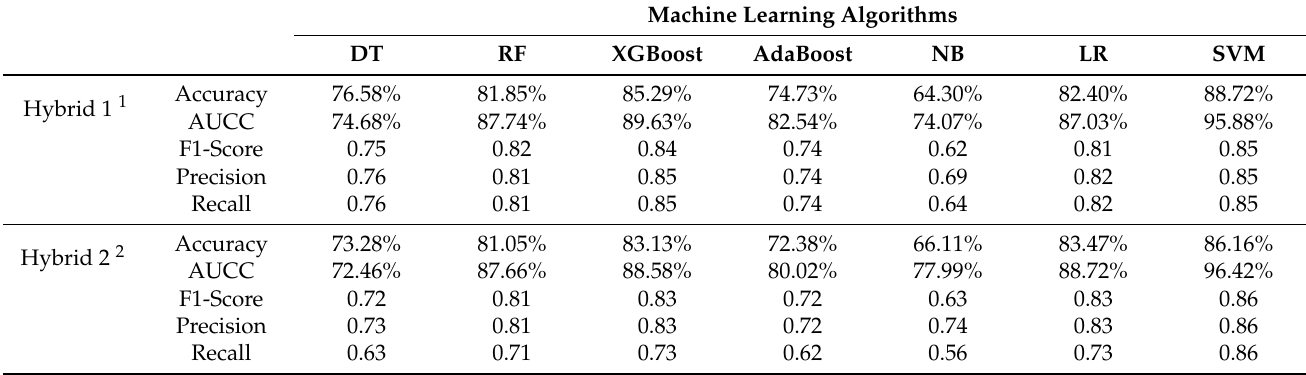
Table 4. Traditional classifier performance using hybrid